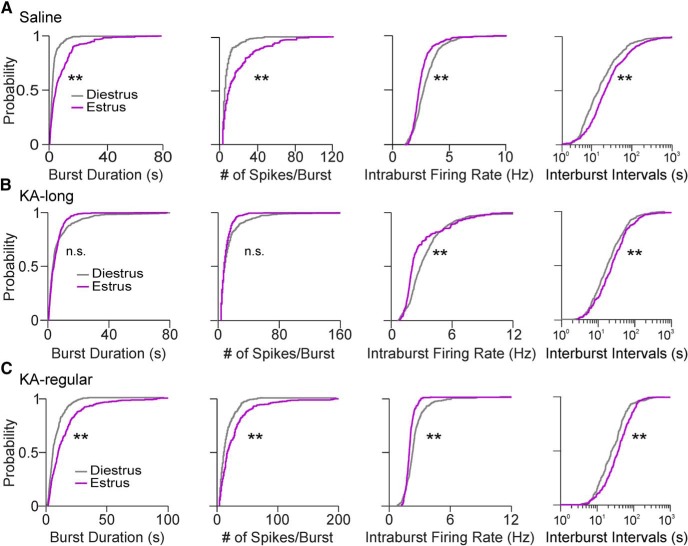
GnRH neuron burst properties on diestrus and estrus; only neurons displaying burst spiking patterns were used for comparisons. A, Cumulative probability distributions for burst properties of GnRH neurons from control female mice on diestrus (gray traces) and estrus (purple traces). Cumulative distributions were constructed using 100 randomly selected bursts per cell. B, Burst properties from KA-long female mice. C, Burst properties from KA-regular female mice; **p < 0.0001 for comparisons by Kolmogorov–Smirnov tests. n.s., not significant. The interburst intervals are presented on logarithmic scales for better visualization of the major portion (1–99%) of the distributions.